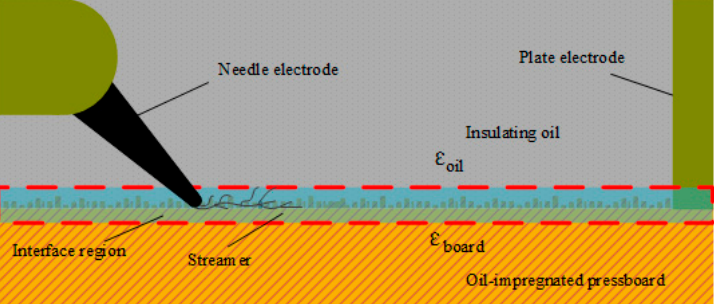
Figure 9. The structure schematic of the oil/pressboard interface.